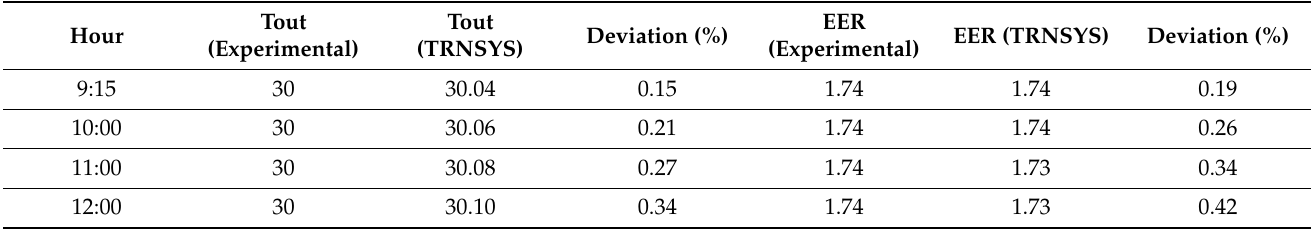
Table 4. Results and deviation of the performance of the simulation and experimental data at 2